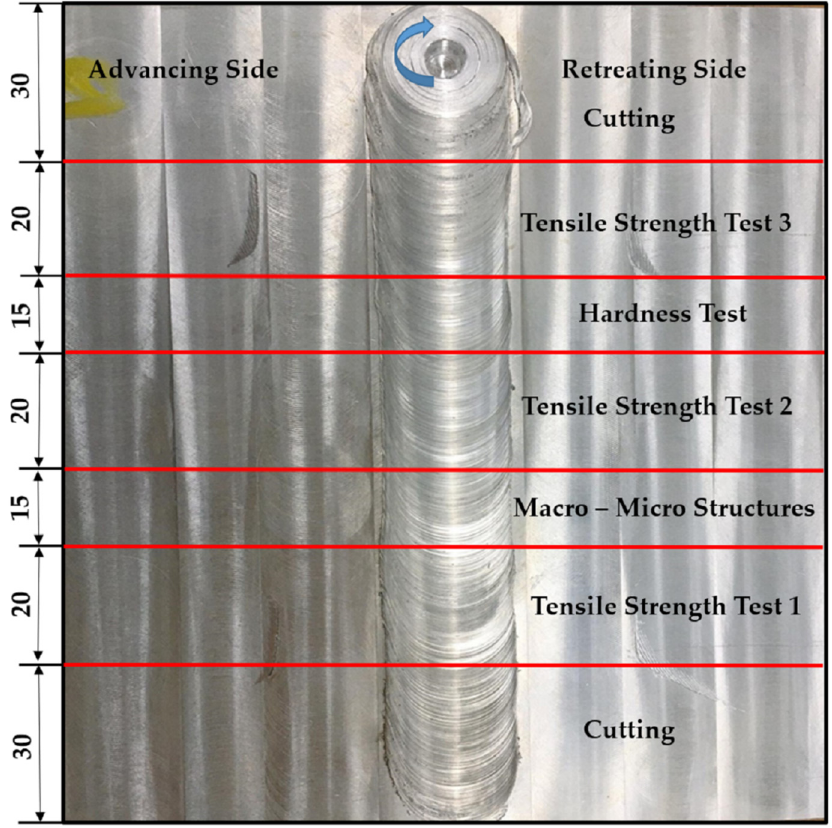
Figure 4. The cutting distance of the welding workpiece for mechanical properties testing and metallurgical structural analysis.